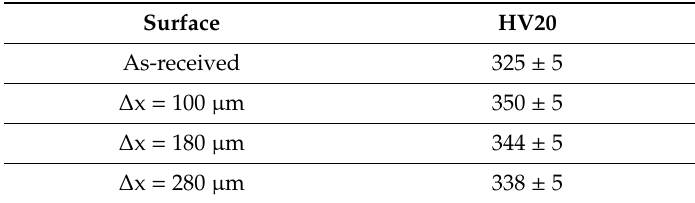
Figure 3. EBSD band contrast image overlapping with the EBSD phase map.